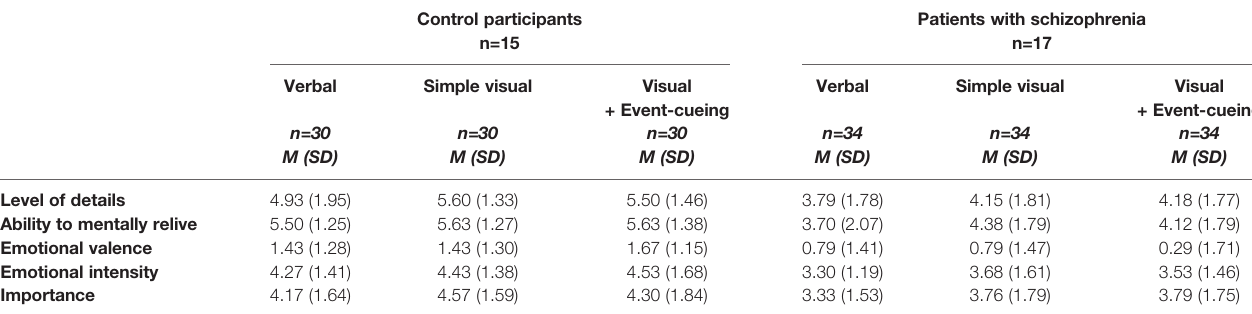
TABLE 3 | Means (M) and standard deviations (SD) of memories characteristics subjectively evaluated by participants during the cued recall task.